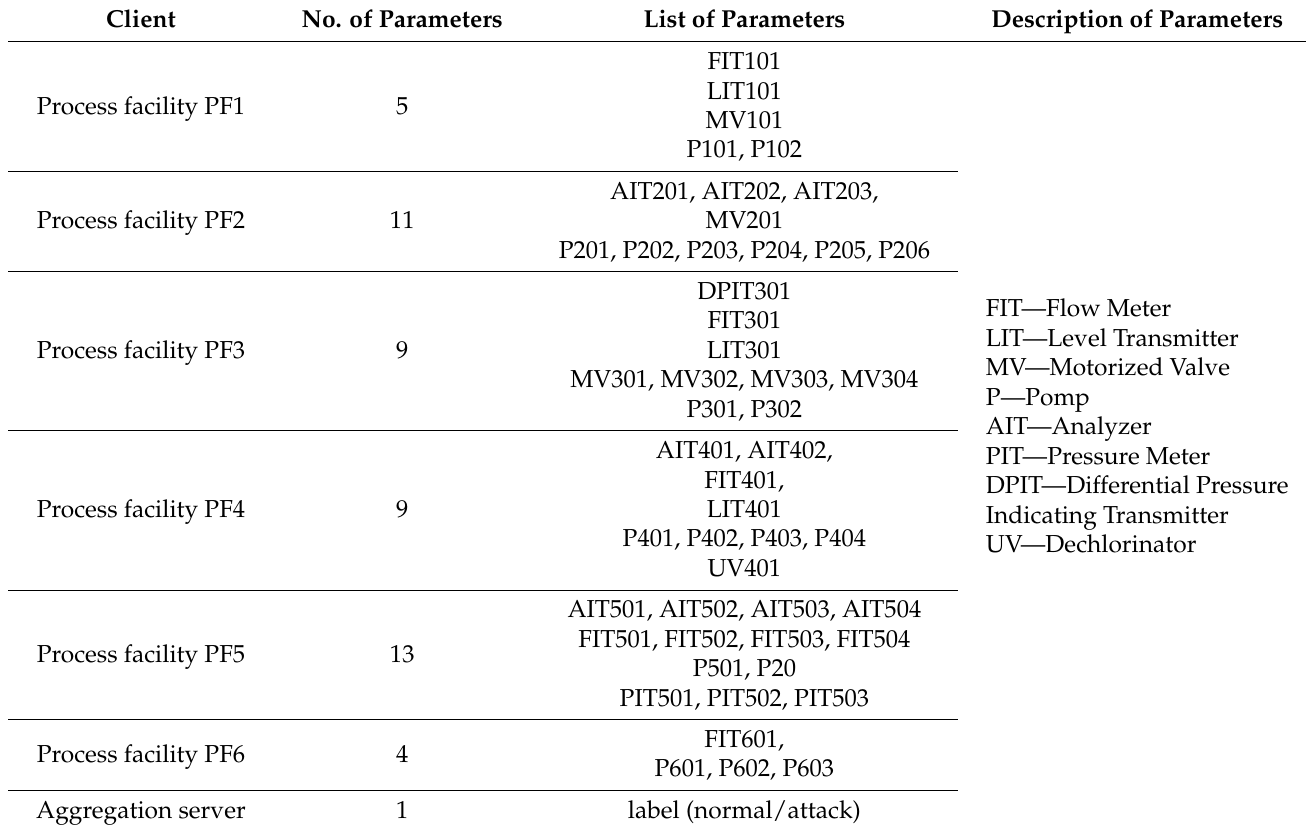
Table 1. The partition of SWaT dataset parameters among process